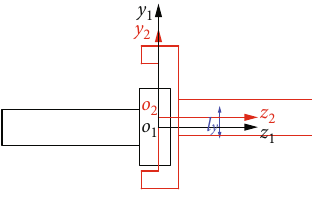
Figure 2: Diagram of the parallel misalignment.